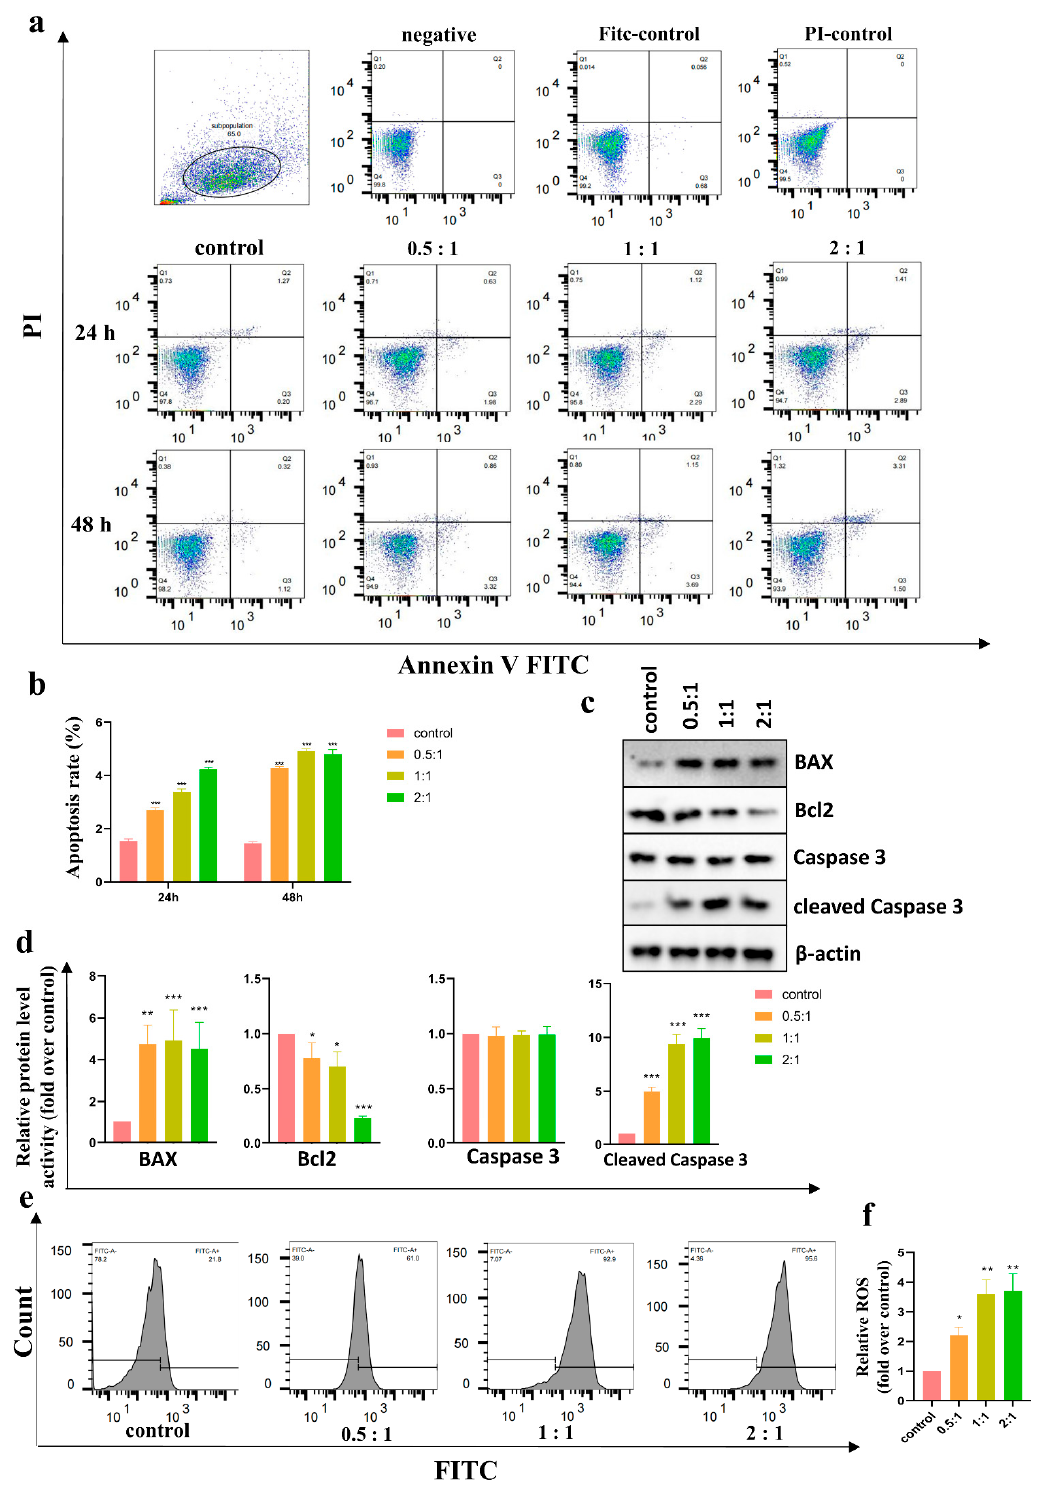
Figure 3. AD-MSCs induced apoptosis of HSFs. ( a ) Examination of apoptotic cells in HSFs after coculturing. The apoptosis of cells was assessed by FACS after 24 h and 48 h. ( b ) Quantitative analysis of the percentage of apoptotic cells as shown in a (n = 3). ( c , d ) The expression analysis of Bcl-2, Bax, Caspase 3, and cleaved Caspase 3 in HSFs of different groups after 48 h with immunoblotting assay (n = 3). ( e , f ) FACS detected the level of intracellular ROS of four groups after coculturing for 48 h. Quantitative analysis was shown in f (n = 3). * p < 0.05, ** p < 0.01, and *** p < 0.001 vs.